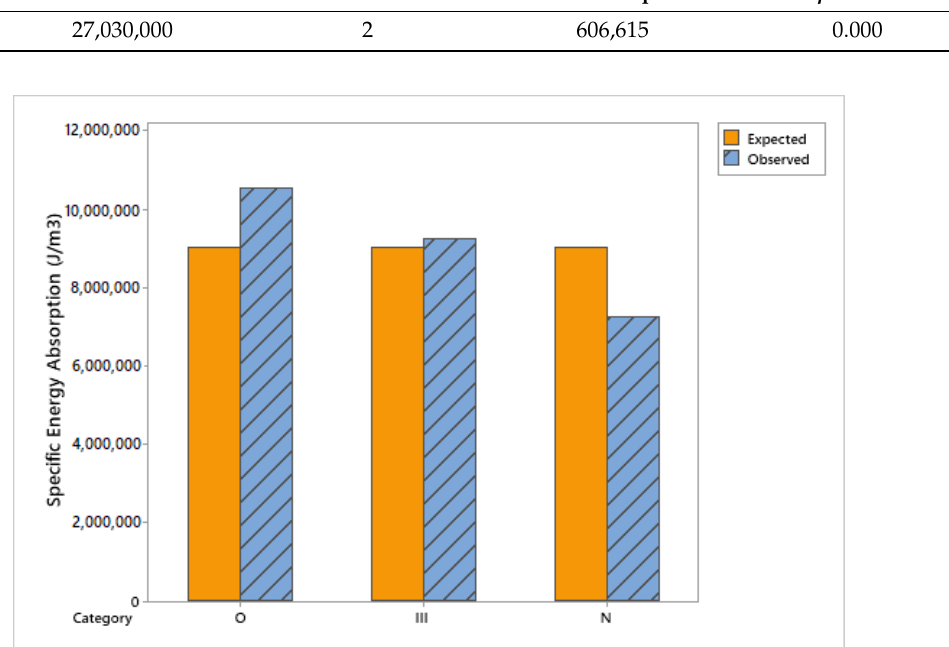
Table 6. The results of the chi-squared test for sample categories.